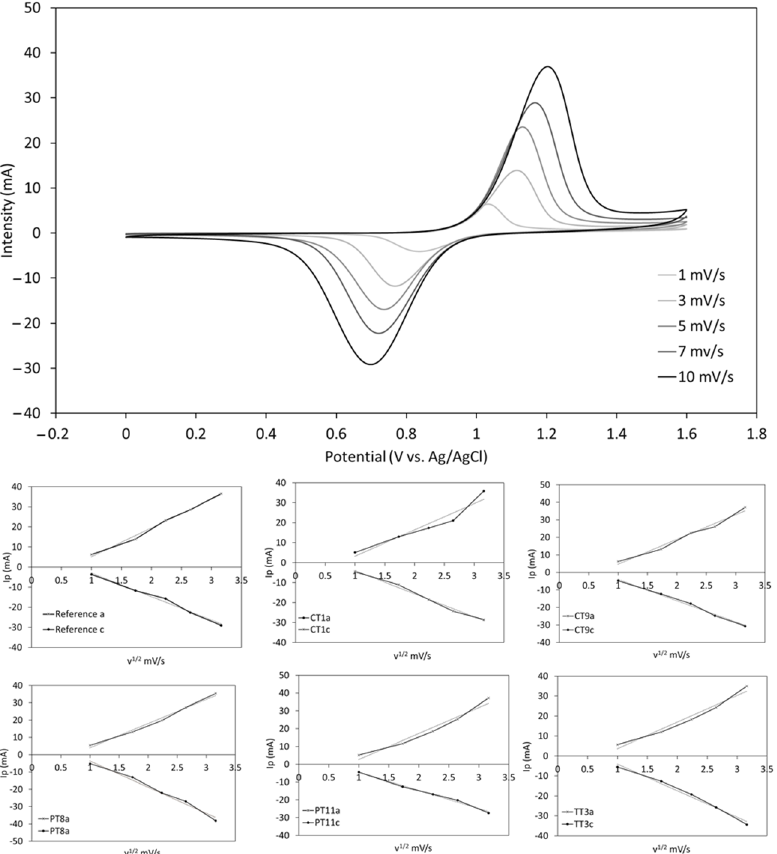
Figure 5. Voltammogram of the reference at different scan rates (1, 3, 5, 7, 10 mV/s). Below, the linear evolution of the peak currents with the scan rate for all the tested electrode treatments, as predicted by the Randles–Sevcik equation.